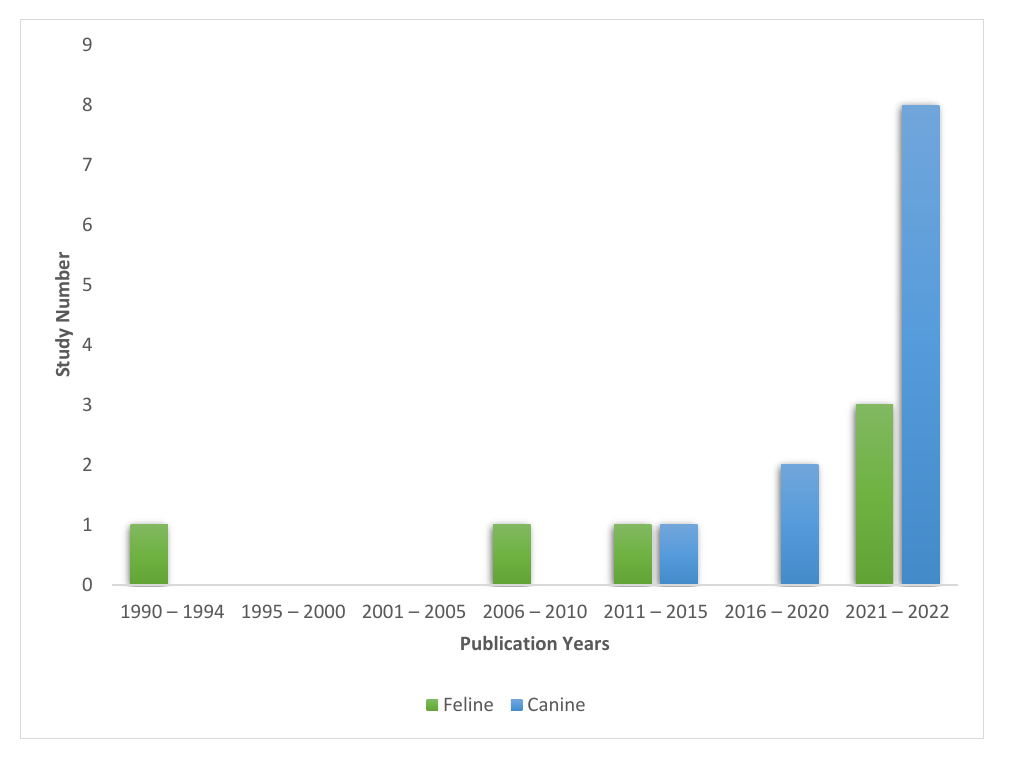
Figure 2. Bar chart illustrating number and years of publication for studies involving dogs and cats fed vegan diets.